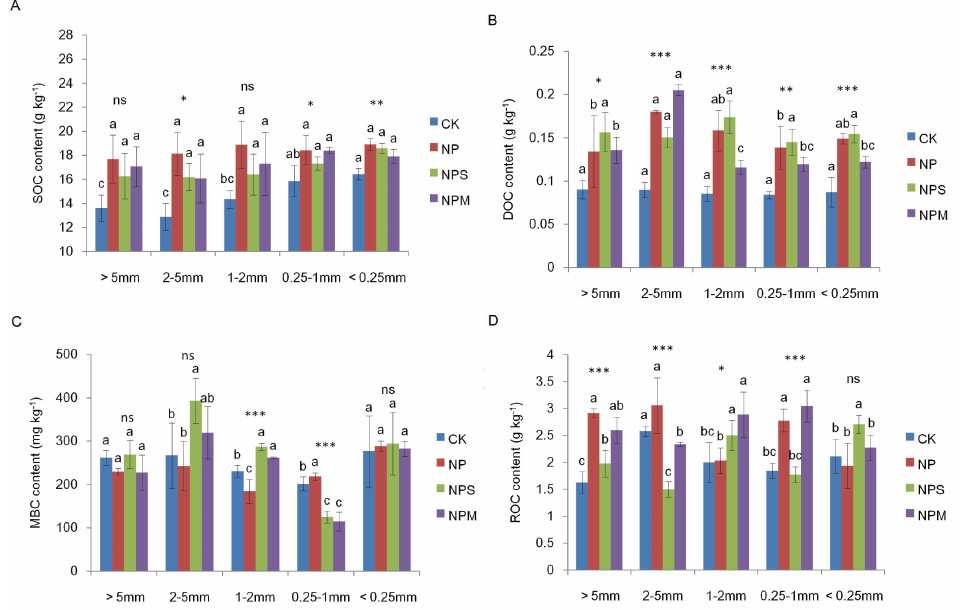
Figure 1. The distribution of SOC ( A ), DOC ( B ), MBC ( C ), ROC contents ( D ) in different aggregates under 4 fertilization managements (CK, NP, NPS, and NPM). SOC: soil organic carbon; DOC: dissolved organic carbon; MBC: microbial biomass carbon; ROC: readily oxidizable organic carbon. Vertical bars indicate the standard error of the mean ( n = 3). Different lowercase letters indicate significant difference at p < 0.05 among the different aggregate sizes. The differences in C contents among the different fertilization managements are shown at *: p < 0.05, **: p < 0.01, ***: p < 0.001, and ns: not significant.